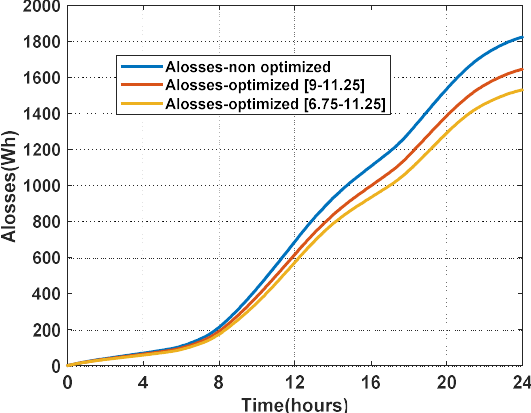
Figure 18. The energy losses (Alosses) of the system in 24 h (interpolation).